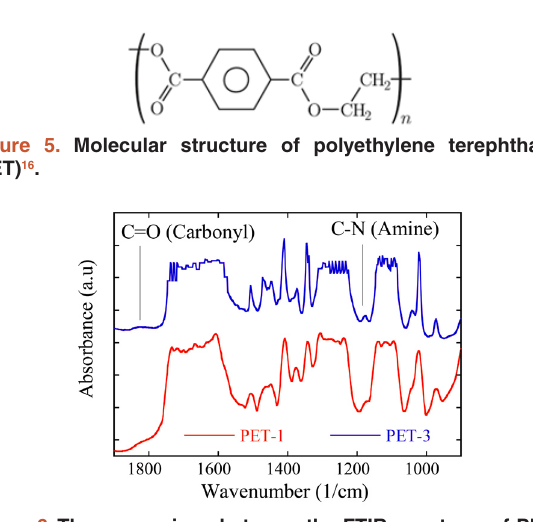
Figure 6. The comparison between the FTIR spectrum of PET-1 and PET-3, a PET/PVP modified membrane. PET-1, no added PVP or evaporation; PET-3, added PVP and no